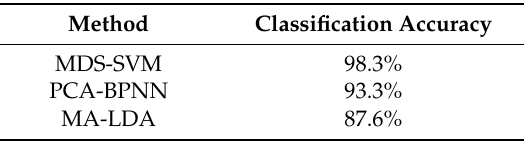
Table 6. Comparison of Classification